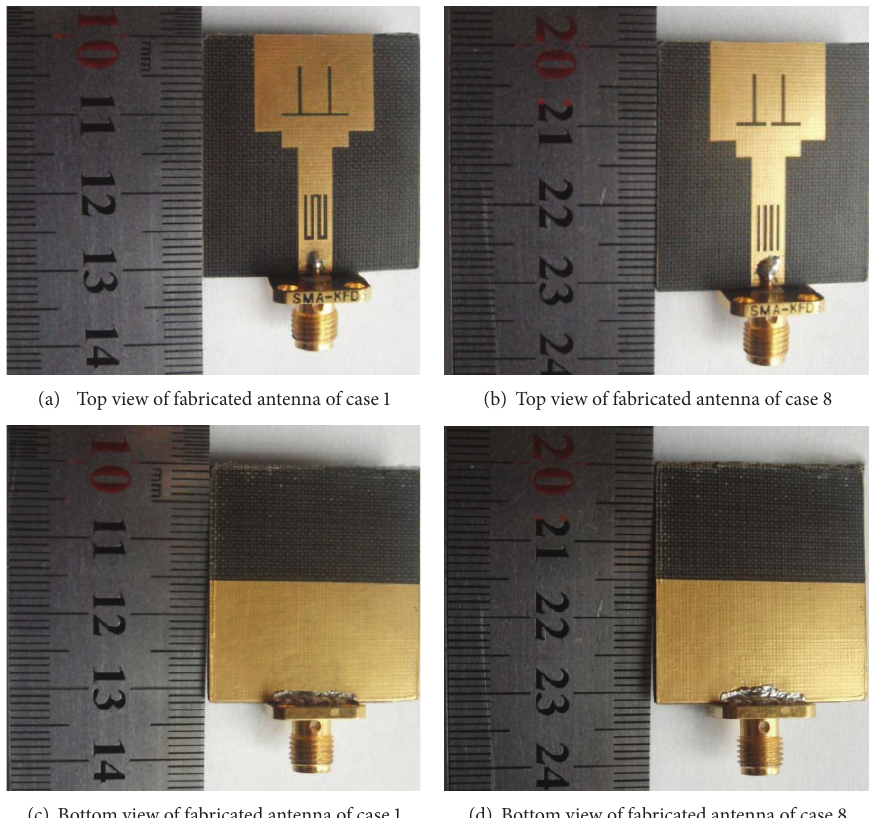
Figure 14: The fabricated CRA C in case 1 and case 8.